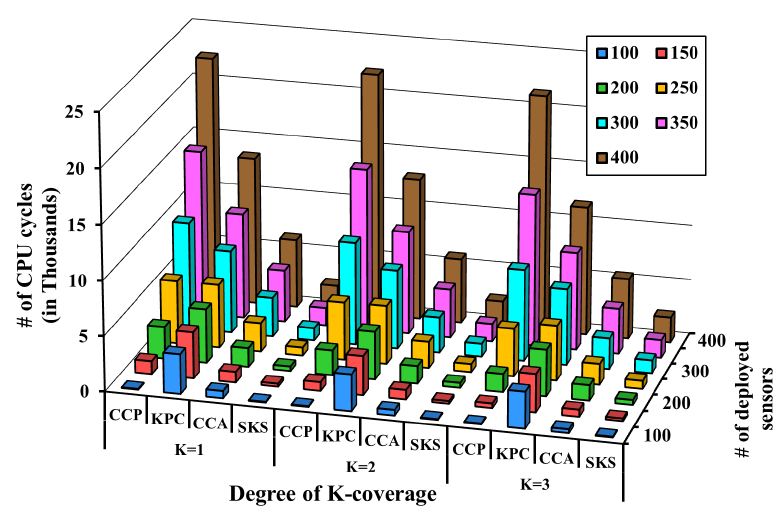
Figure 12. The performance comparison of the Coverage Configuration Protocol (CCP) [6], the K -Perimeter-Covered (KPC) algorithm [7], CCA [31] and the proposed Self-Organized K -coverage Scheduling (SKS) under different K -coverage degrees with respect to the computational